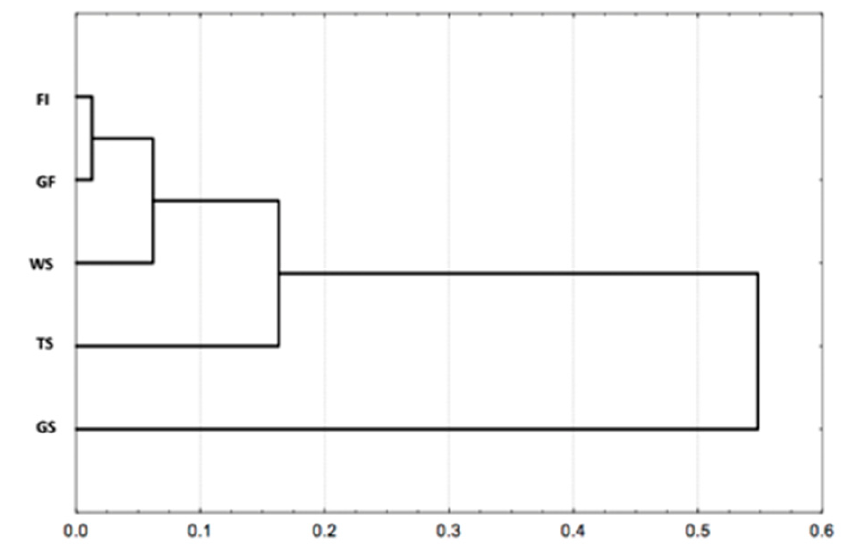
Figure 2. Classification of visited habitat types based on their respective termite’s species composition using the nearest-neighbor method (Unweighted Pair-Group Method using Arithmetic Averages), with 1—Jaccard index as the distance between groups. Abbreviations: FI = Forest Island, GF = Gallery Forest, WS = Woodland Savanna, TS = Tree Savanna, GS = Grassy Savanna.